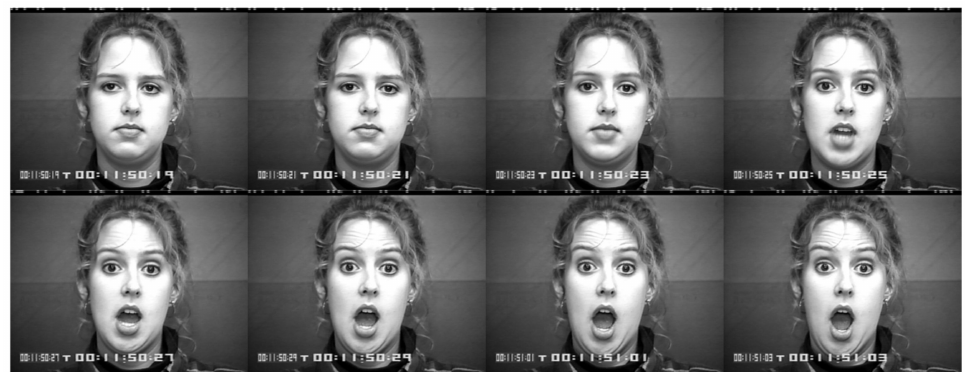
Figure 5. Example of CK+. Subjects are first familiarized with various facial action units, and then combine facial action units to make expressions under the direction of the